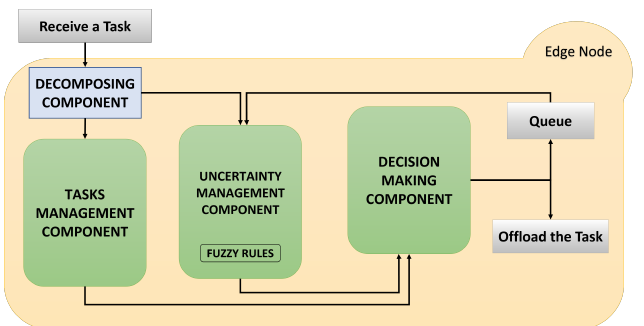
Figure 2. Components that constitute